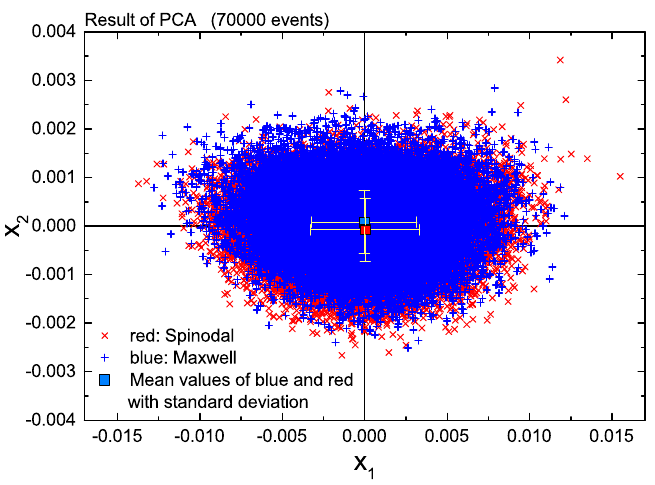
Figure 7 . Scatter plot of the (cid:12)rst two components of a PCA of the distribution of the momentum di(cid:11)erence for baryon pairs. The red crosses indicate the events with the spinodal instabilities, which dominate the southern hemisphere, while the blue pluses indicate events with a Maxwell construction. The large symbols with error bars near the center indicate the mean values with their standard deviation. The spinodal EoS creates a clear crescent of crosses in the southern hemisphere, x 2 < 0. Also the mean value is shifted downwards